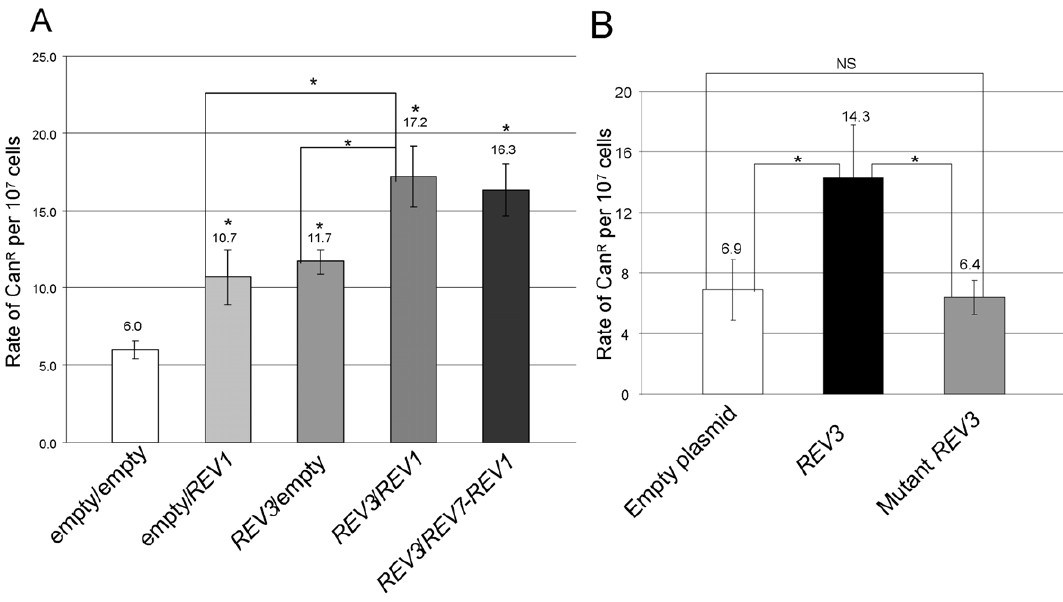
Figure 7. Rate of Can R mutants. Rate of Can R mutants (A) in wt strains overexpressing REV3 , REV7 and/or REV1 or (B) wt REV3 and mutant REV3 , encoding for the Rev3 protein harboring the 504–508 AAAAA stretch. Rate of Can R mutants was measured as indicated in Materials and Methods on three independent clones. If no stated differently, * indicates that the rate is significantly different from that of strain transformed with the empty plasmid(s). NS: not significant.